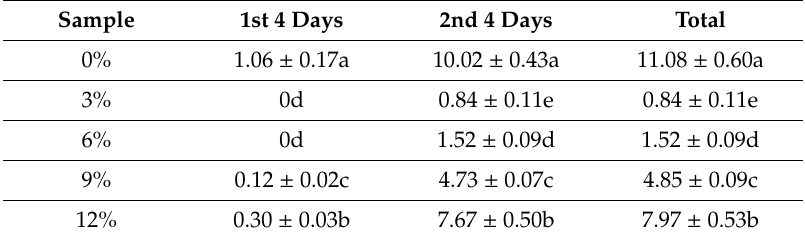
Table 3. Percentage syneresis from the cornstarch gels as a function of gum Cordia